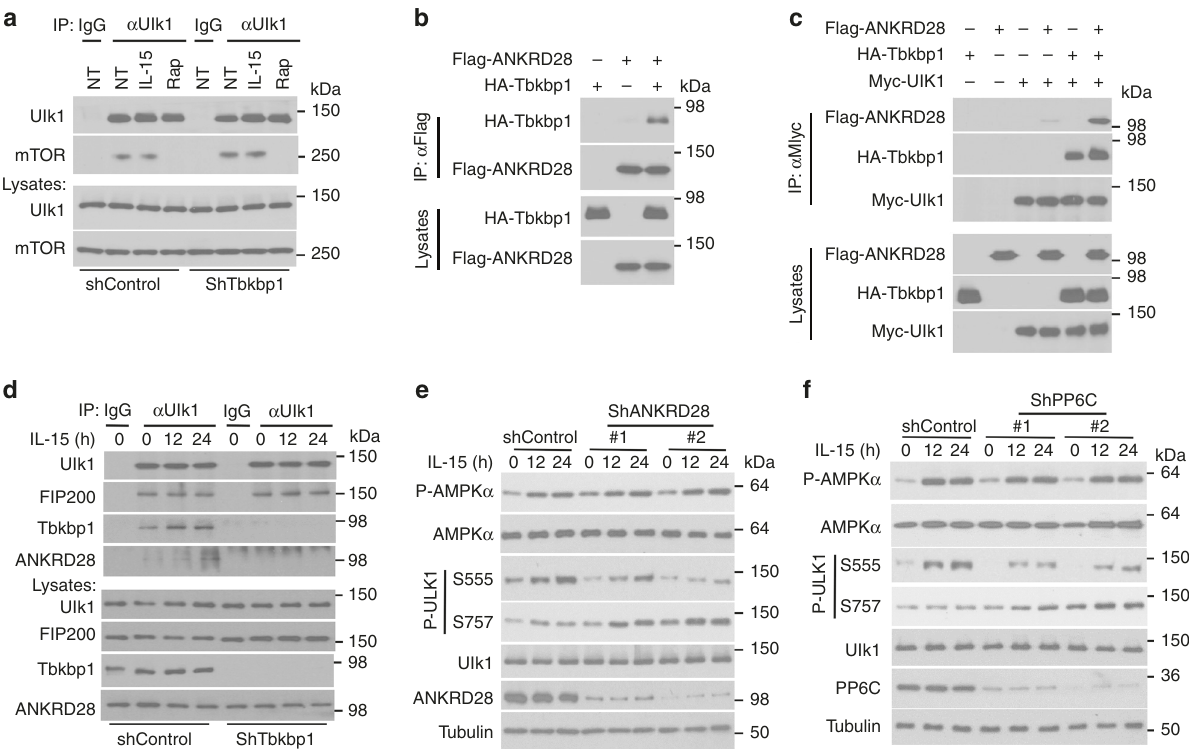
Fig. 8 Tbkbp1 recruits PP6 to Ulk1 to oppose mTORC1-mediated Ulk1 phosphorylation. a Co-IP analysis of mTOR-Ulk1 interactions (upper panels) and direct IB analysis of the indicated proteins (lower panels) in NKT hybridoma cells transduced with a control or Tbkbp1-speci fi c shRNA, either not treated (NT) or incubated with IL-15 or the mTORC1 inhibitor rapamycin (Rap). IgG was used as a negative control for IP. b Co-IP analysis of Tbkbp1-ANKRD28 interactions and direct IB assays using lysates of HEK293 cells transfected with the indicated expression vectors. c Co-IP analysis of ULK1 association with Tbkbp1 and ANKRD28 using lysates of HEK293 cells transfected with the indicated expression vectors. d Co-IP analysis of Ulk1 interaction with FIP200, Tbkbp1, and ANKRD28 using lysates of IL-15-stimulated NKT hybridoma cells transduced with a control or Tbkbp1-speci fi c shRNA. IgG was used as a negative control for IP. e , f IB analysis of the indicated phosphorylated (P-) and total proteins in whole-cell lysates of IL-15-stimulated NKT hybridoma cells transduced with a nonsilencing control shRNA, two different ANKRD28-speci fi c shRNAs ( e ) or two different PP6c-speci fi c shRNAs ( f ). Data